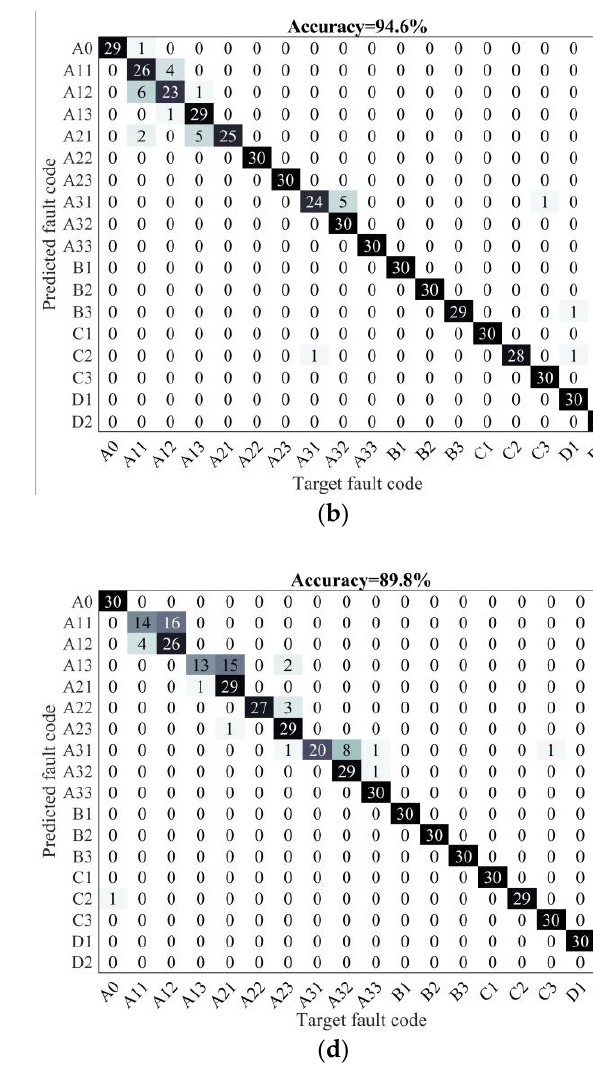
Figure 8. Prediction confusion matrices of the representative algorithms with different input features, ( a ) Ours-MFCC; ( b ) Ours-STFT; ( c ) SVM-Linear-MFCC; ( d ) ResNet-18-STFT. The color of each grid changes from white to black, corresponding to 0-30. The darker the color is, the more samples of that type of fault are predicted.